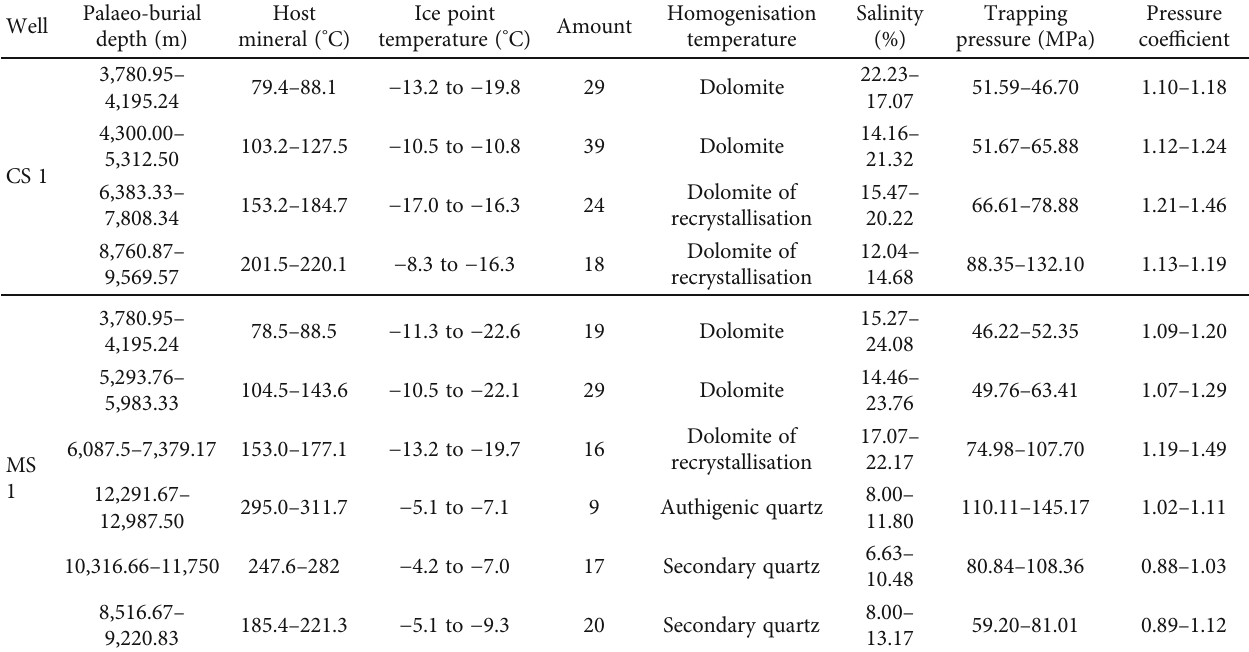
Table 2: Major data from the fl uid inclusion analysis (modi fi ed from